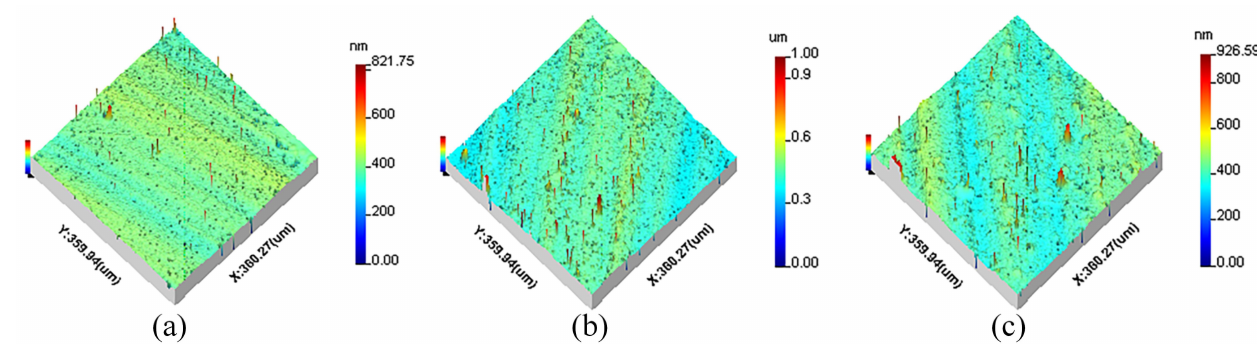
Figure 3. The original 3D surface topography of different spindle speeds: ( a ) n = 1300 r/min, ( b ) n = 1400 r/min, ( c ) n = 1500